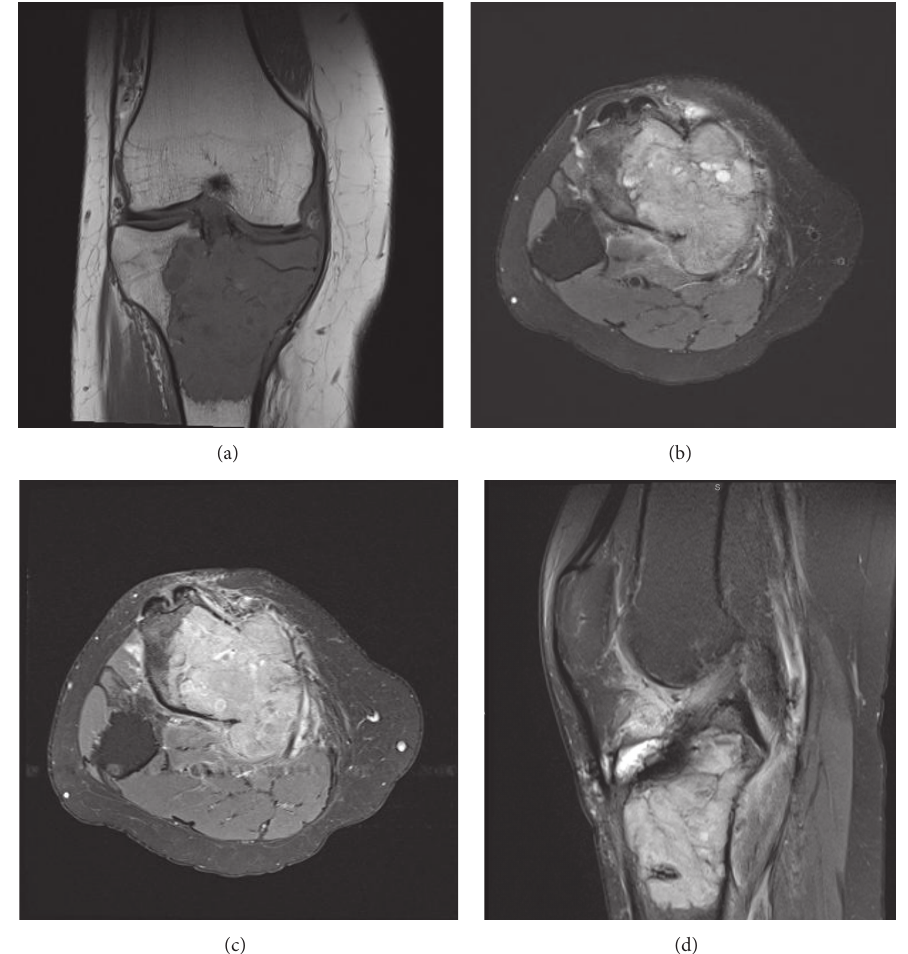
Figure 7: Coronal T1 weighted (a), axial fat suppressed proton density (b), and axial fat suppressed T1 postcontrast (c) images show enhancing bony lesion involving the tibial plateau with cortical breakthrough posteriorly. Selective lateral fat suppressed proton density (d) shows no evidence of other lesions in the distal femur and